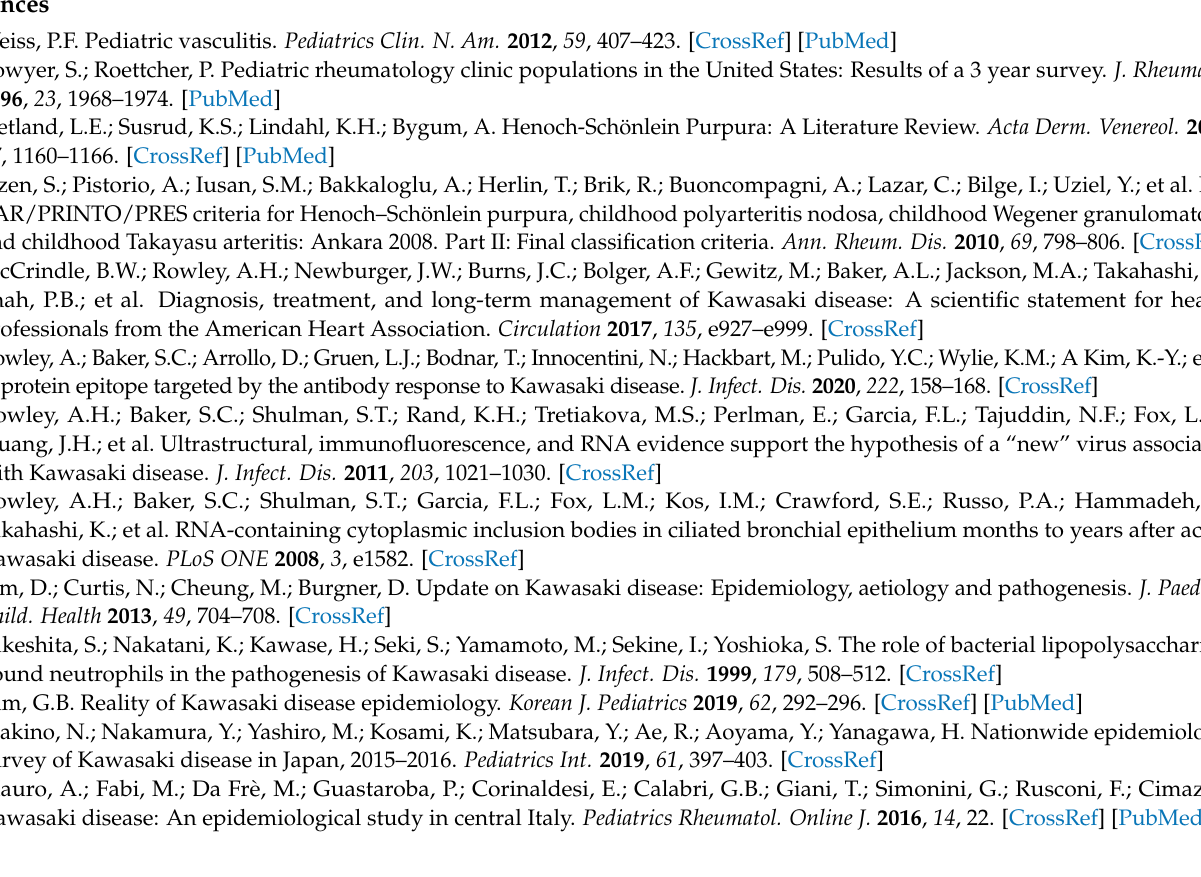
children; Figure S3: Associations between genus-level relative abundances and levels of C-reactive protein in paediatric patients with Kawasaki disease, Henoch–Schönlein purpura and non-KD febrile illness; Figure S4: The GM dysbiosis in paediatric patients with Kawasaki disease, Henoch– Schönlein purpura and non-KD febrile illness is independent of potential confounding factors; Figure S5: The gut microbiota profiles of paediatric patients with Kawasaki disease tend to stratify by response to therapy; Figure S6: Associations between genus-level relative abundances and levels of inflammatory/immunological parameters in paediatric patients with Kawasaki